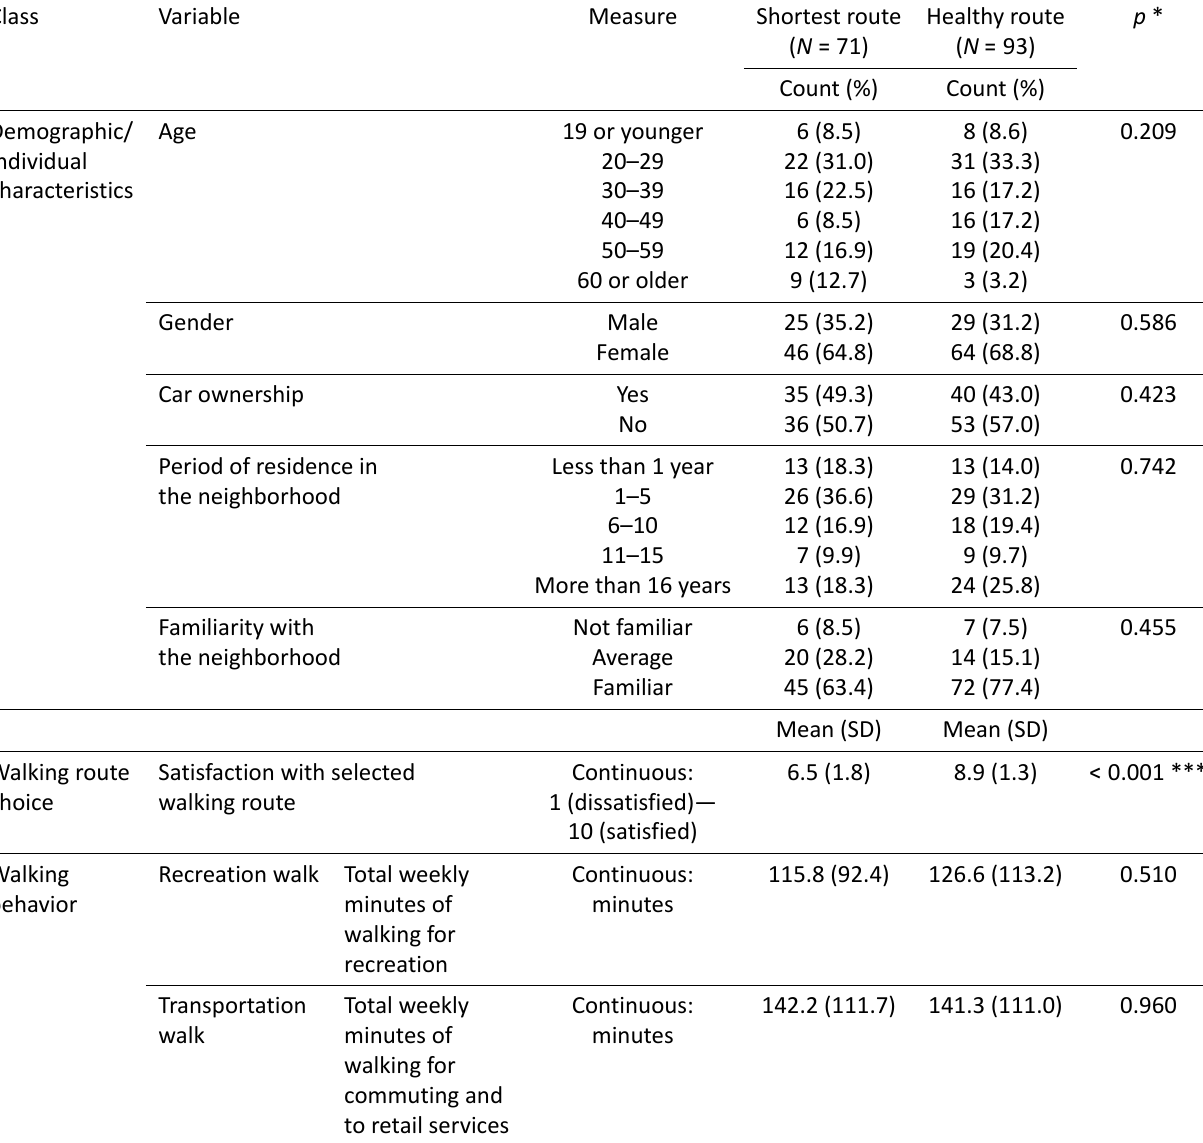
Table 1. Comparison of individual characteristics and perceptions between healthy and the shortest route choices using t and chi‐square